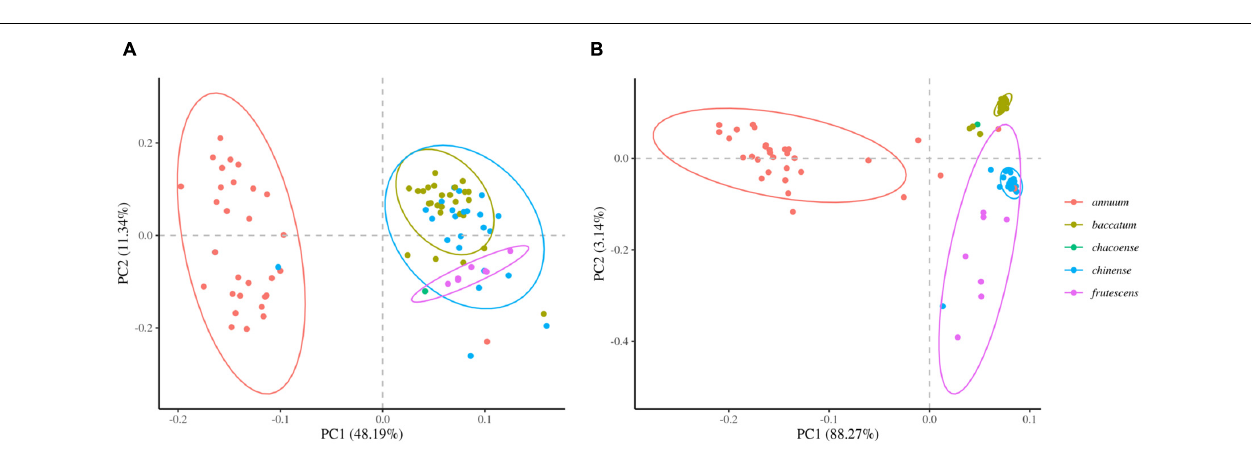
FIGURE 4 | Comparison of genotypes between the Fluidigm system and GT-seq. (A) Distribution of genotype frequencies at 288 loci, as determined by the Fluidigm system. (B) Distribution of genotype frequencies at 288 loci by GT-seq. (C) Distribution of fluorescent genotype makers by Fluidigm. (D) Distribution of GT-seq genotypes that were the same individuals at the same markers.